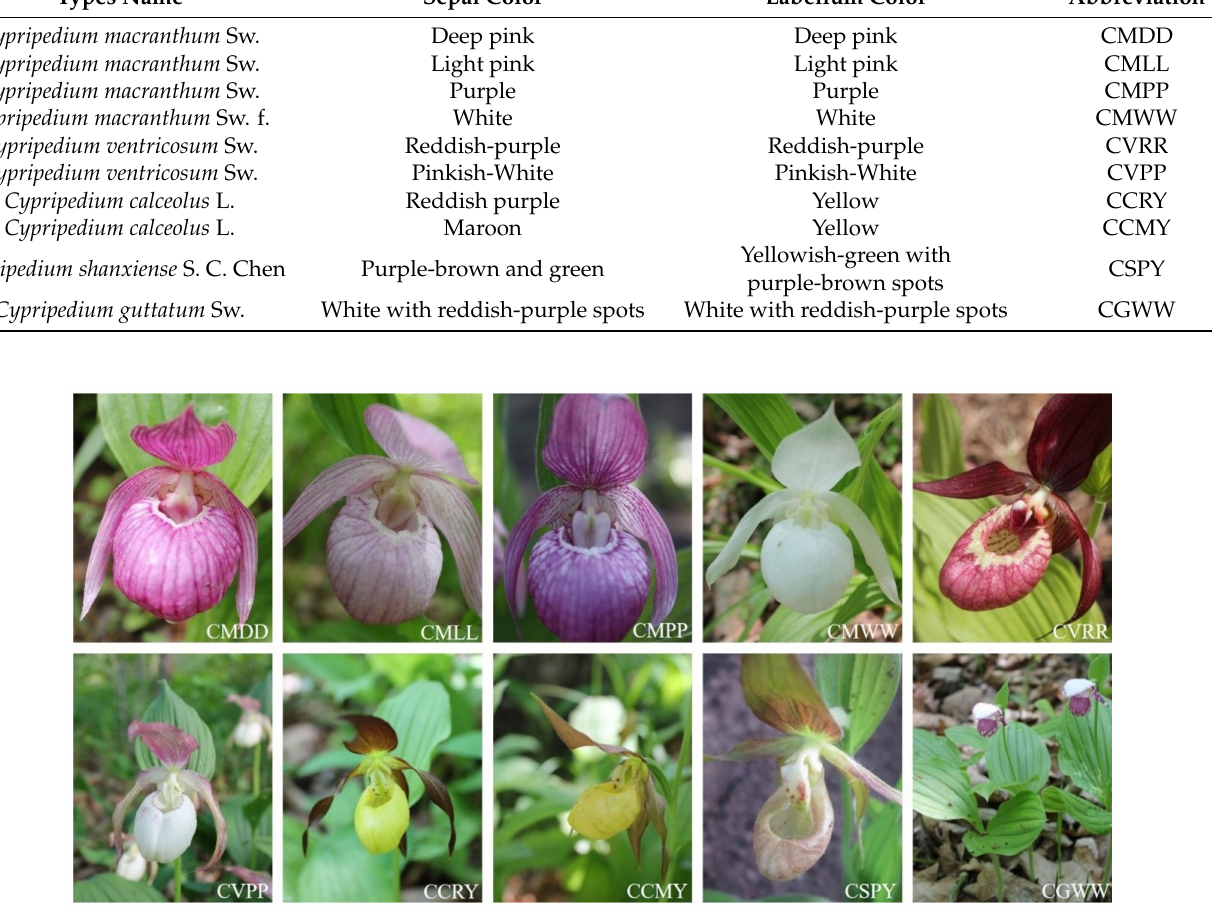
Figure 1. The 10 samples of Cypripedium CMDD, CMLL, CMPP, CMWW, CVRR, CVPP, CCRY, CCMY, CSPY, and CGWW as shown in the